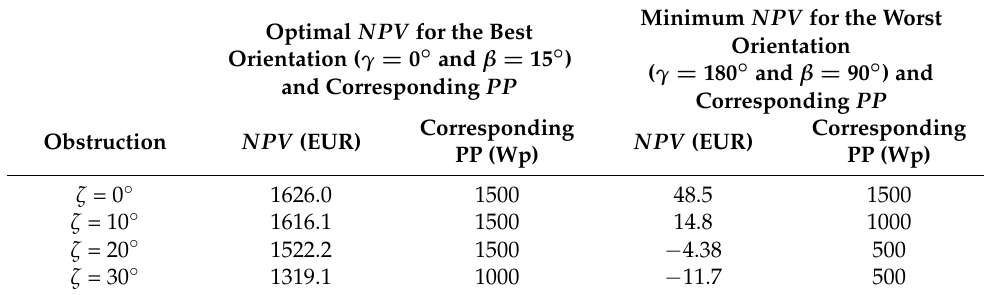
Table 9. Optimal and minimum NPV for different levels of obstruction.